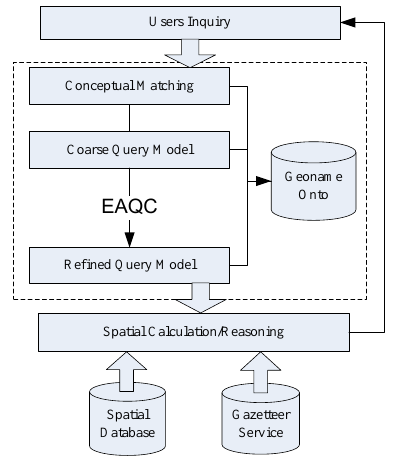
Figure 4. The structure of direction relation query model